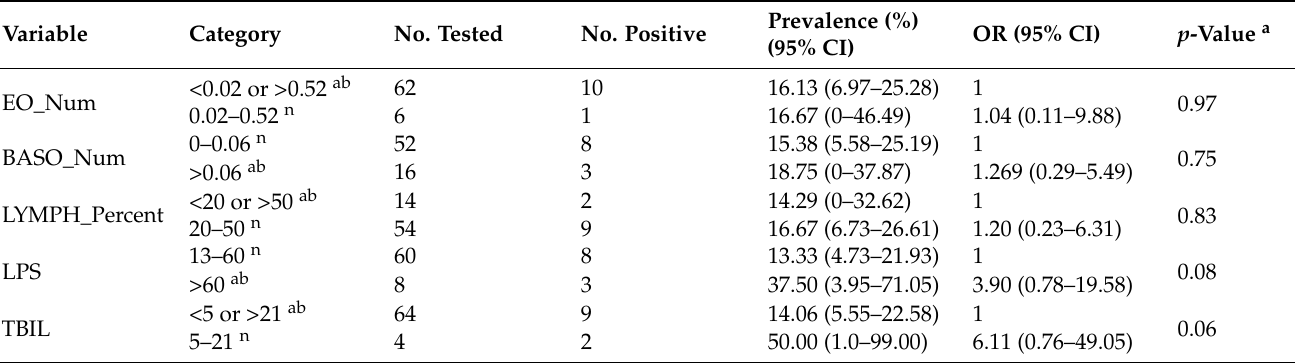
Table 3. Prevalence and factors associated with Blastocystis infection in blood routine and blood biochemical indexes of hydatidosis patients in Qinghai,